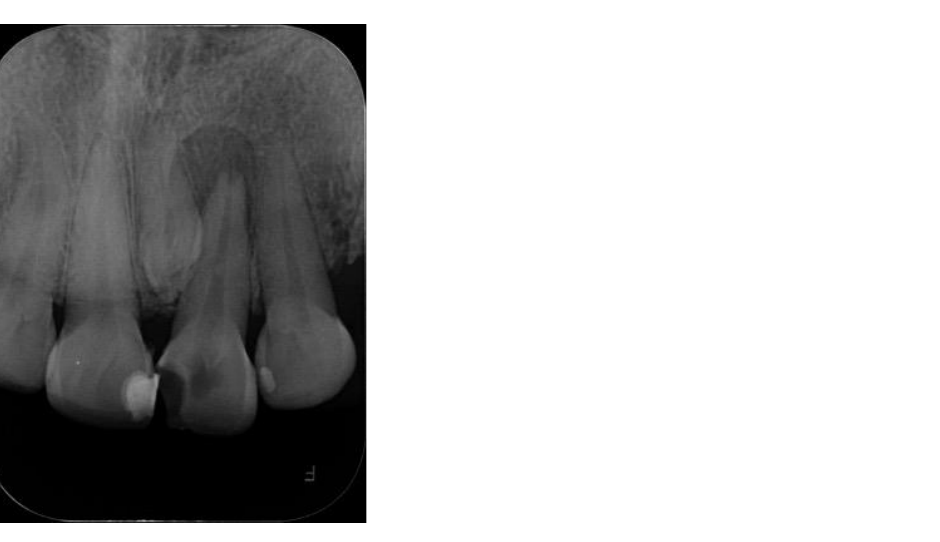
Figure 2. Periapical X-ray showing supernumerary tooth located between tooth 1.1 and 2.1. Mesiodens crown overprojected in mesial root profile of tooth 2.1. Periapical osteolytic radiolucent area with clear non-corticalized limits.